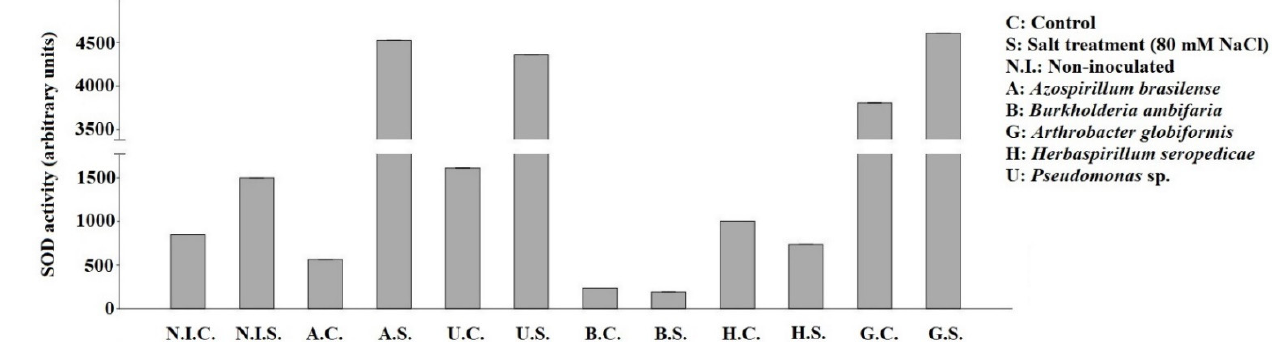
Figure 4. SOD activity of B. napus grown in non-saline (C) and in saline soils (S).